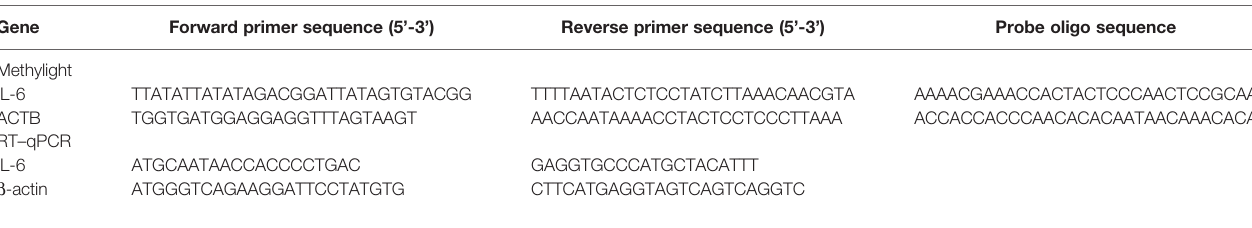
TABLE 1 | Sequences of the primers and probes